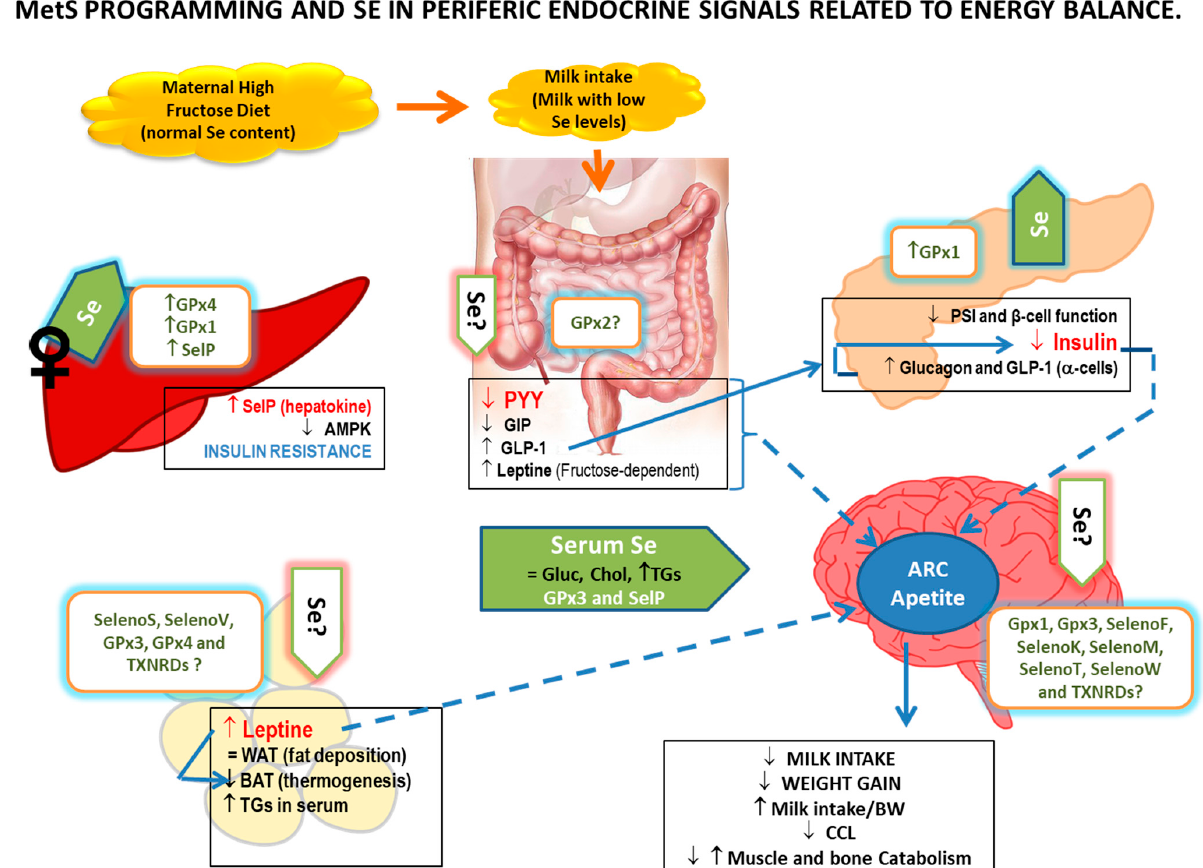
Figure 6. MetS programming and Se in peripheric endocrine signals related to energy